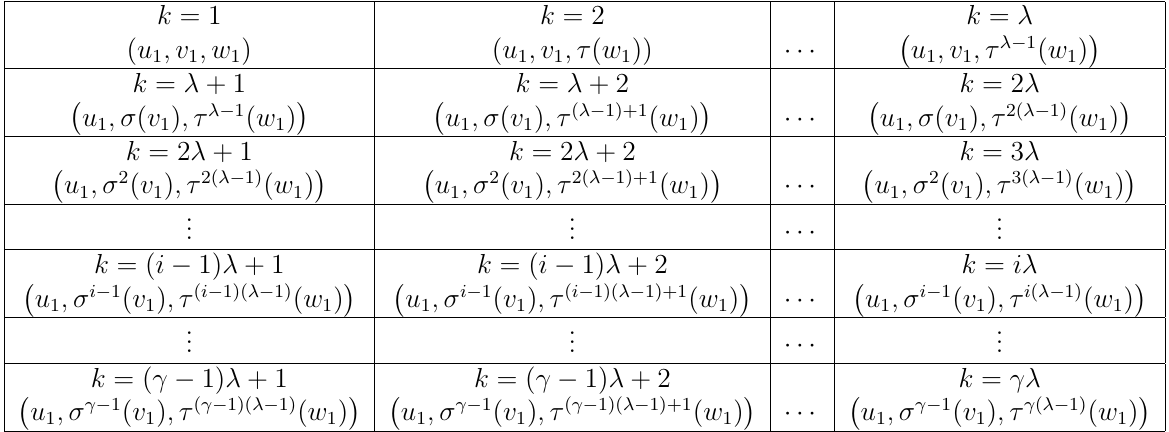
(cid:8) (cid:9) A ( k ) , corresponding to the seeds of K